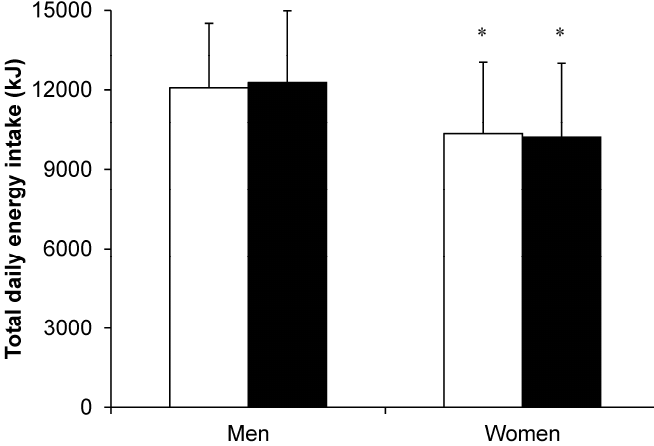
Figure 4. Total daily energy intake before ( □ ) and after ( ■ ) a 12 ‐ week aerobic exercise training intervention in overweight and obese men ( n = 35) and women ( n = 72). Total daily energy intake was quantified objectively using laboratory-based test meal days at Weeks 0 and 12. On each day, participants were provided with an individualised fixed-energy breakfast (ad libitum at Week 0), fixed-energy lunch, ad libitum dinner and evening snack box. * Significant difference between women and men p ≤ 0.05. Values are mean (SD). Data from reference [8]. © Wolters Kluwer Health, Inc. Reproduced with permission.